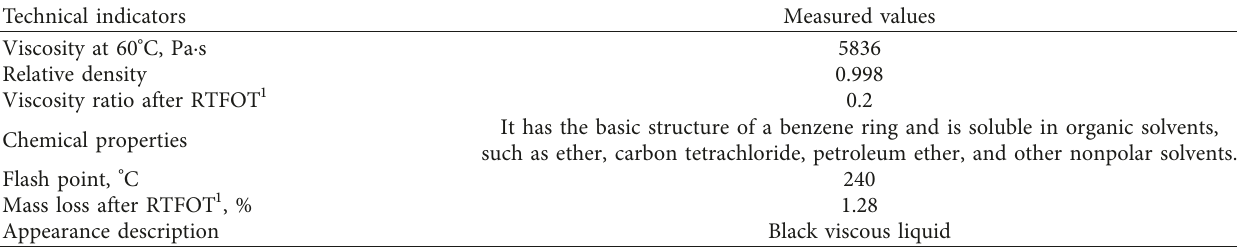
Table 1: Technical indicators of high-performance asphalt regenerant.